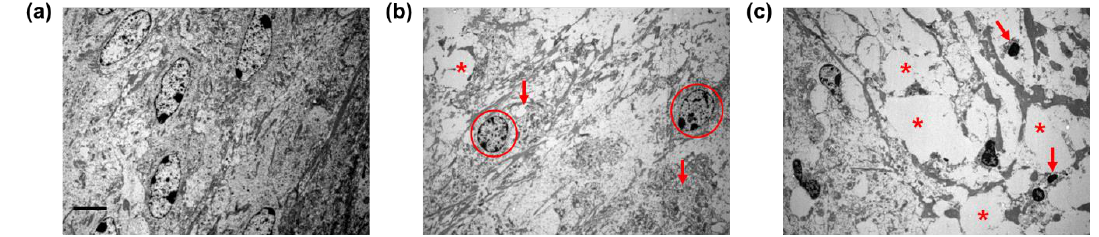
Figure 3. Ultrastructural analysis of spiral ligament type IV fibrocytes before (normal control) and 14 d after TTS or PTS. ( a ) Normal spiral ligament presented cylindrical, spindle-shaped type IV fibrocytes. ( b ) Type IV fibrocytes at 7 d after TTS showed swollen spherical nuclei (circles), cellular debris (red arrows), and vacuolization (asterisk). ( c ) PTS induced massive cytoplasmic vacuolization (asterisk) in the type IV fibrocytes and displayed several apoptotic bodies (red arrows). Scale bar represents 2 μm. n = 3.